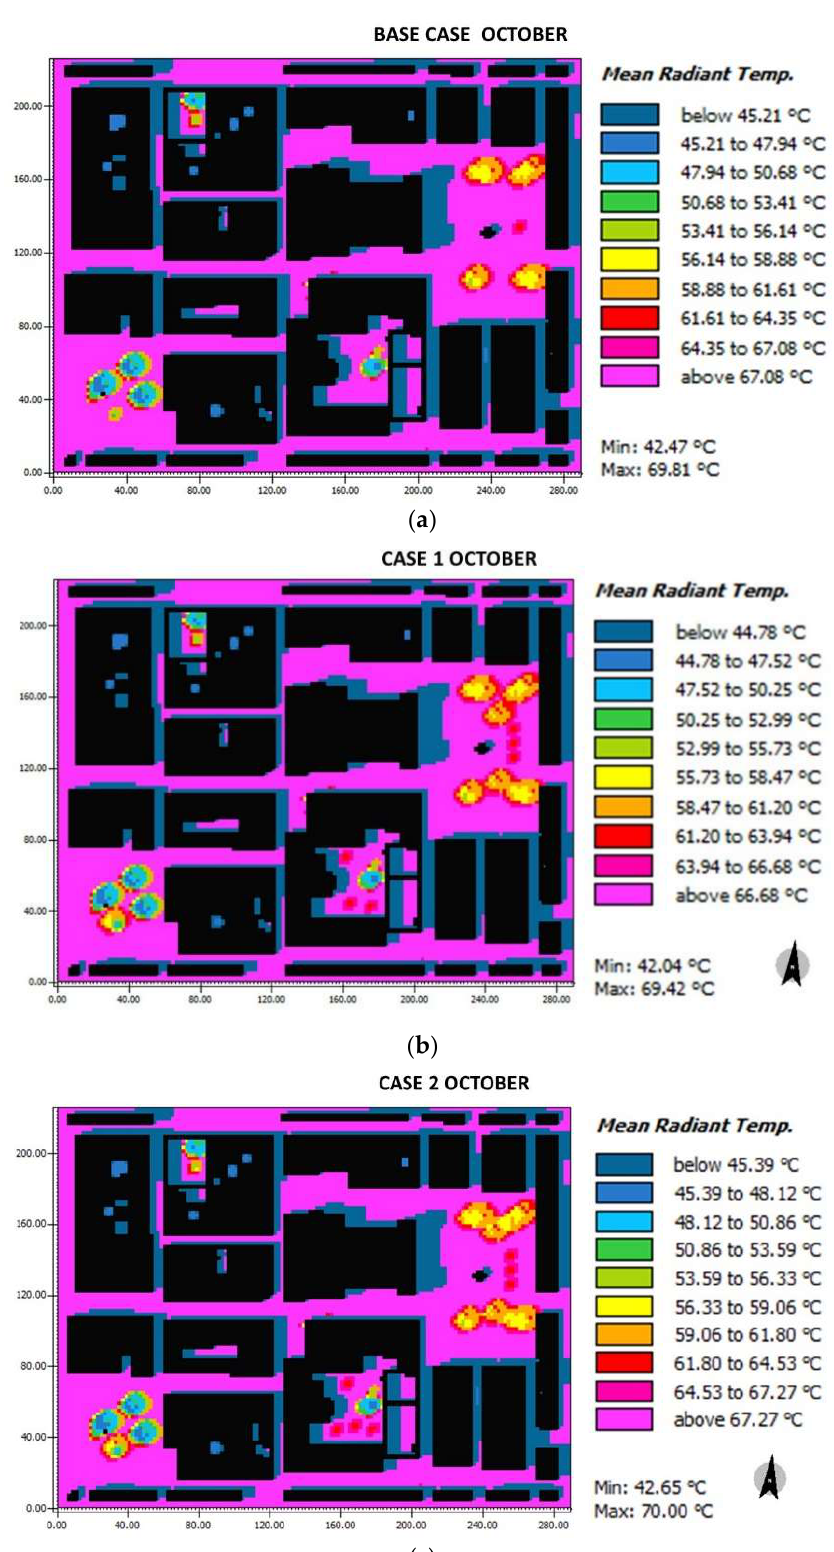
Figure 14. Results maps for mean radiant temperature for October at 15:00: ( a ) base case, ( b ) case 1, and ( c ) case 2.